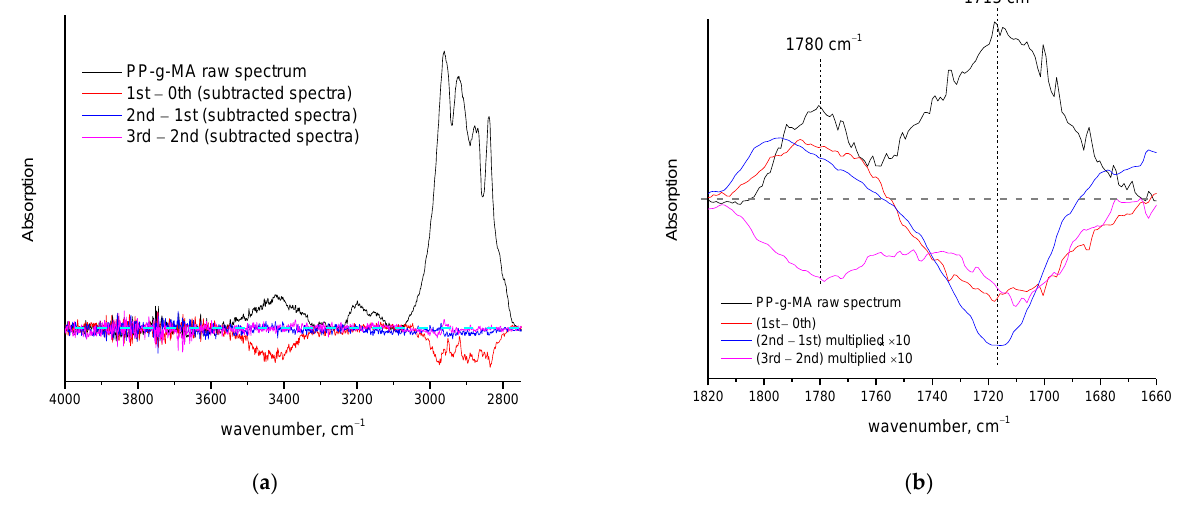
Figure 4. FTIR spectrum of PP-g-MA raw material and subtracted spectra before and after three consecutive heating cycles at 170 °C: ( a ) region 4000–2750 cm −1 ; ( b ) region 1820–1660 cm −1 .